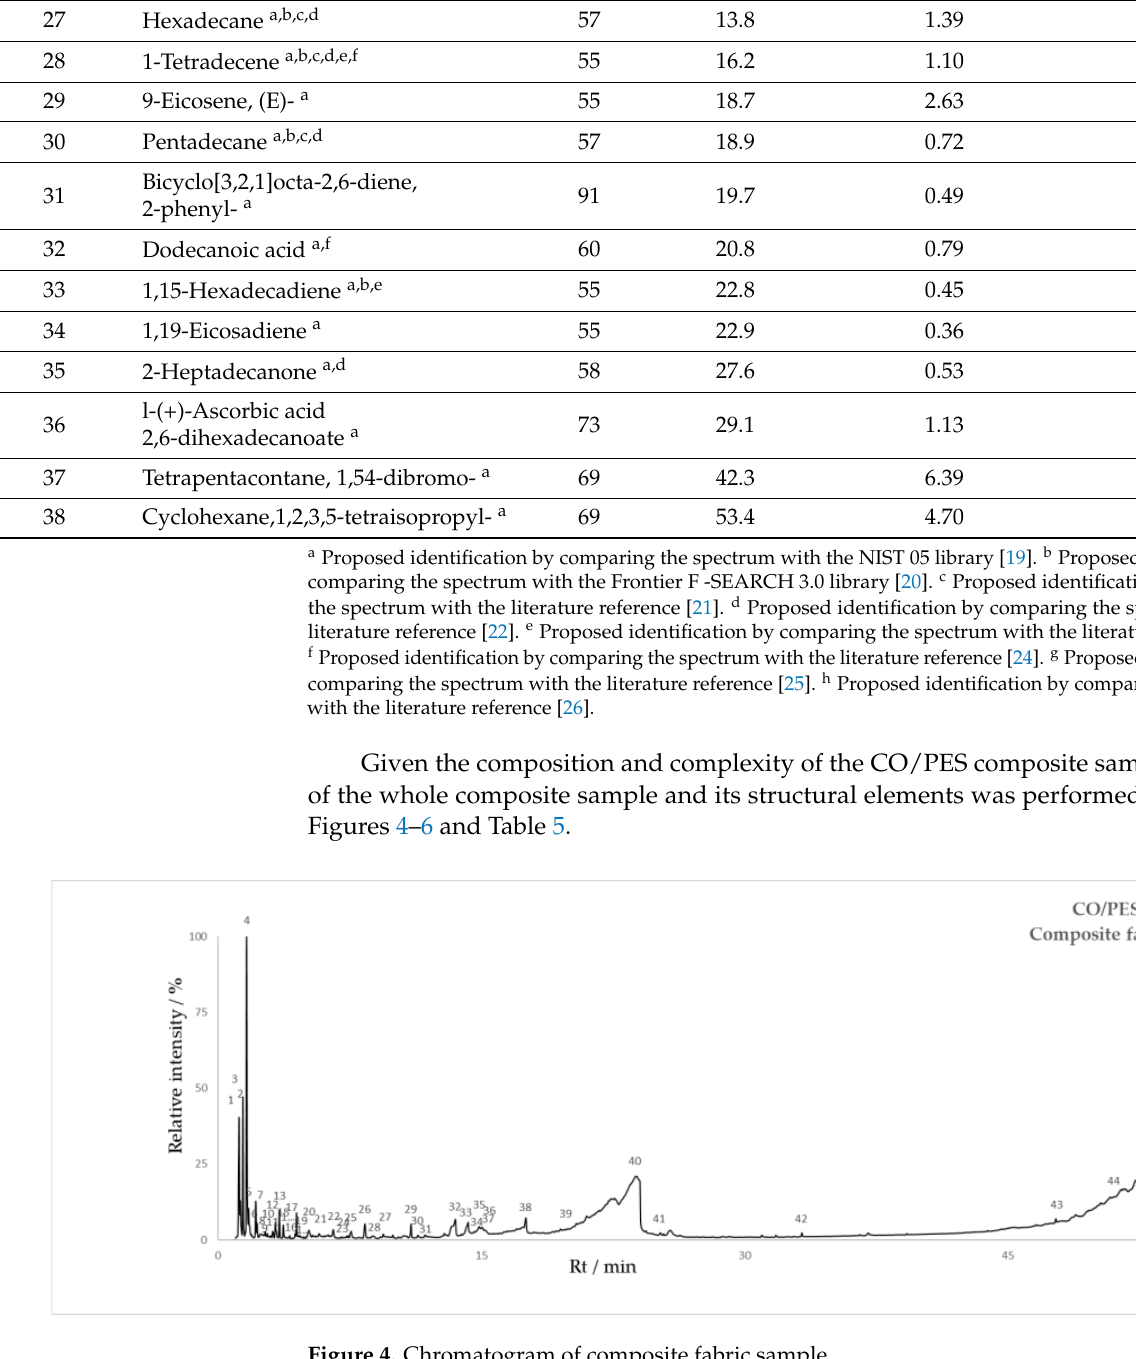
Figure 5. Chromatogram of warp yarn as structural unit of cotton cellulose in blend with polyester.